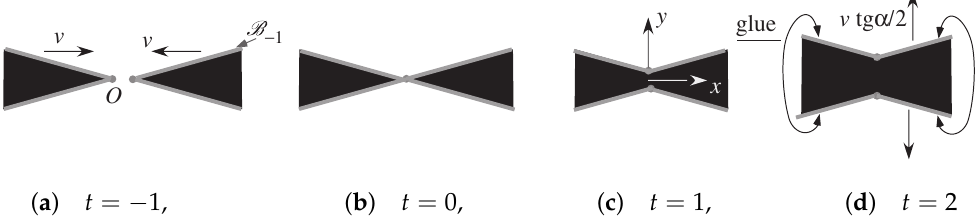
Figure 3. The cross sections t = const of N (the white area) and of ∂ N (the gray rays). S C is a pair of strings merging into a single resting one.